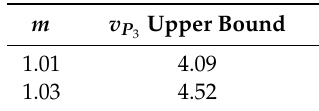
Table 7. Step by step results: Displacement v P